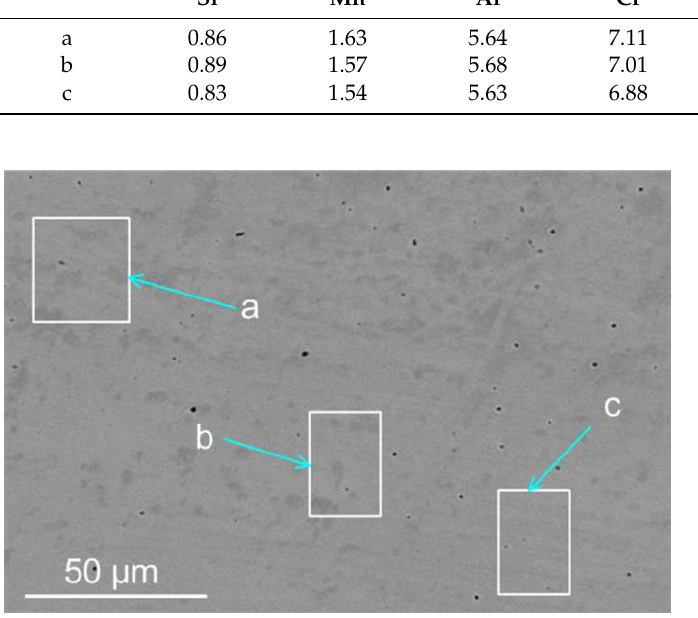
Figure 1. SEM BSE (backscattered electron) micrograph of weld metal analyzed areas (×1500). Table 4. SEM-EDS analyses of areas in Figure 1